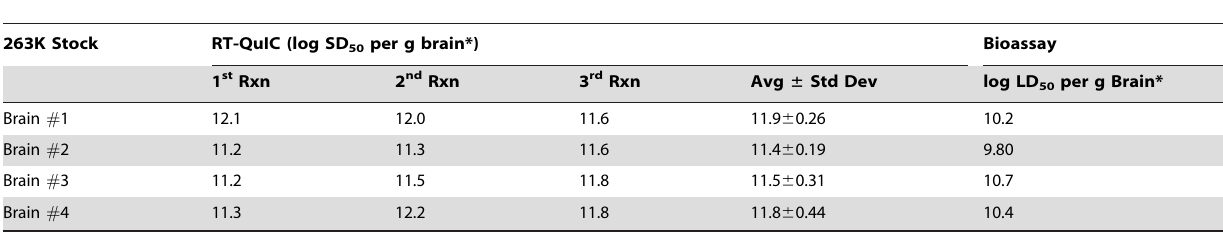
Table 1. RT-QuIC and animal bioassay end point dilution analyses.